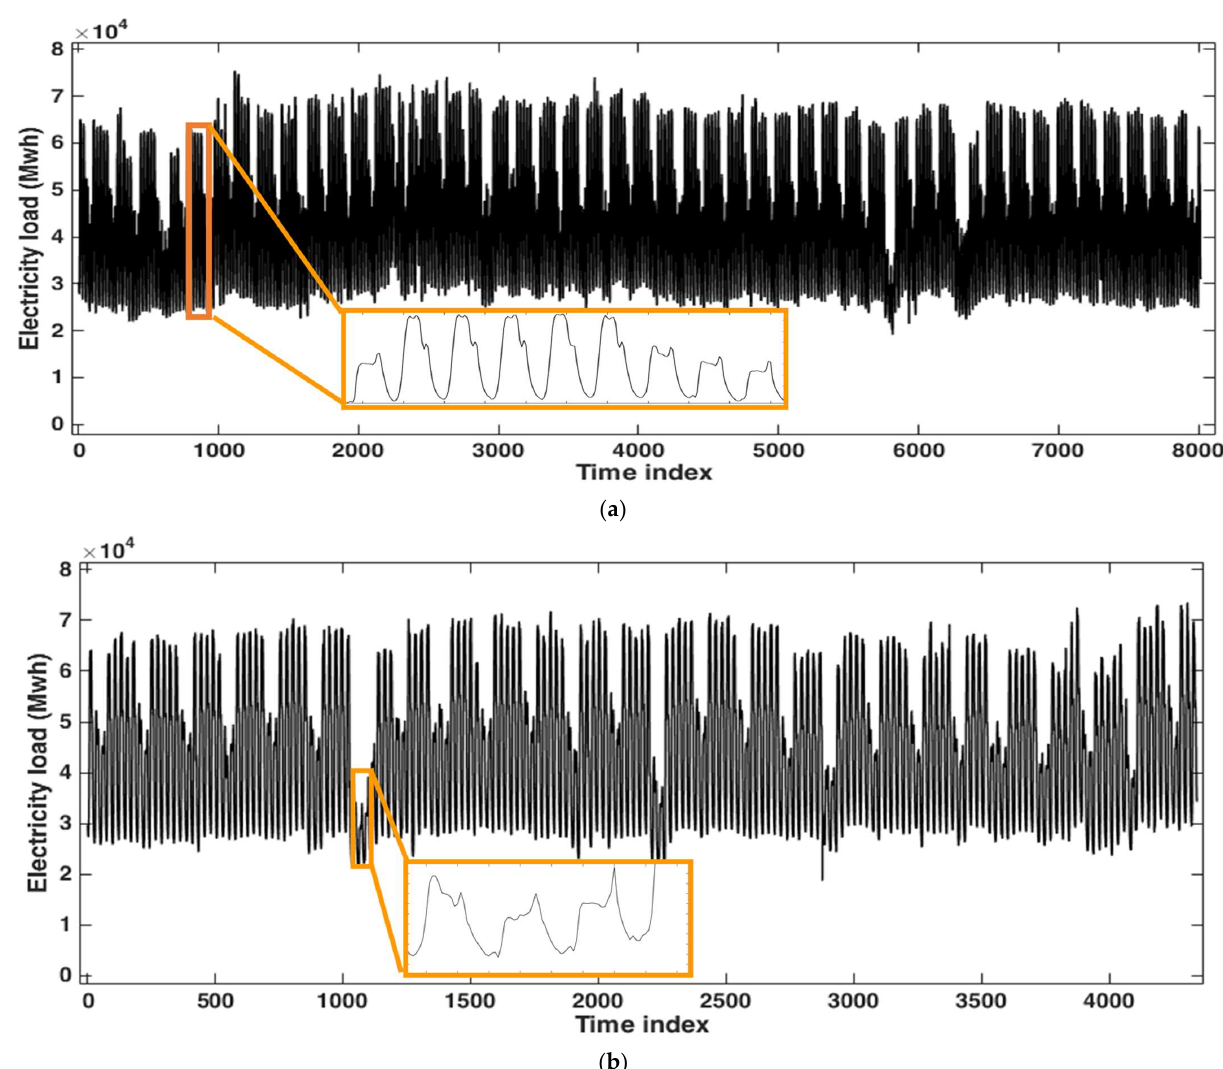
Figure 2. Hourly load series of Johor, Malaysia: ( a ) 1 January time 00:00, to 30 November 2009, time 23:00; ( b ) 1 January, time 00:00, to 30 June 2010, time 23:00. The period from 1 January, time 00:00, to 30 November 2009, time 23:00, and the period from 1 January, time 00:00, to 30 June 2010, time 23:00, were used for estimation purposes as the training data. The remainder was used to evaluate the forecast performance of the models. These periods are summarized in Table